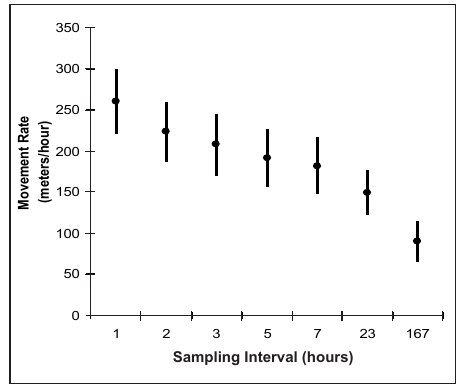
Fig. 3. Average movement rates (m/h) and 95% confi- dence intervals of female caribou based on dif- ferent sampling intervals, winter 1998–1999, For- tymile Caribou Herd,